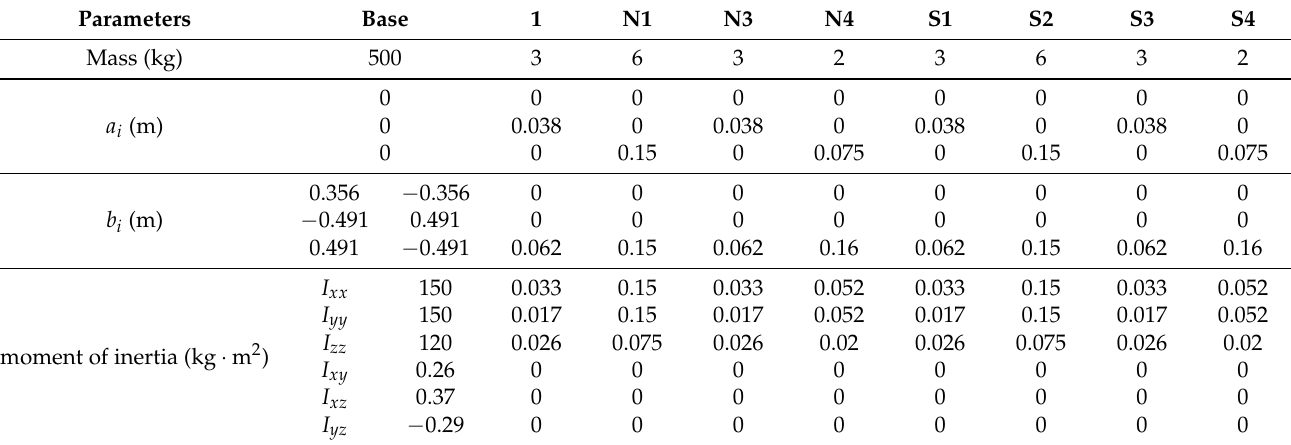
Table 1. Spacecraft